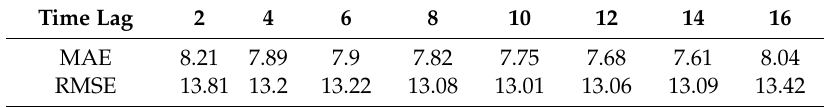
Table 3. E ff ect of di ff erent time lags. MAE—mean absolute error; RMSE—root-mean-square error. Time Lag